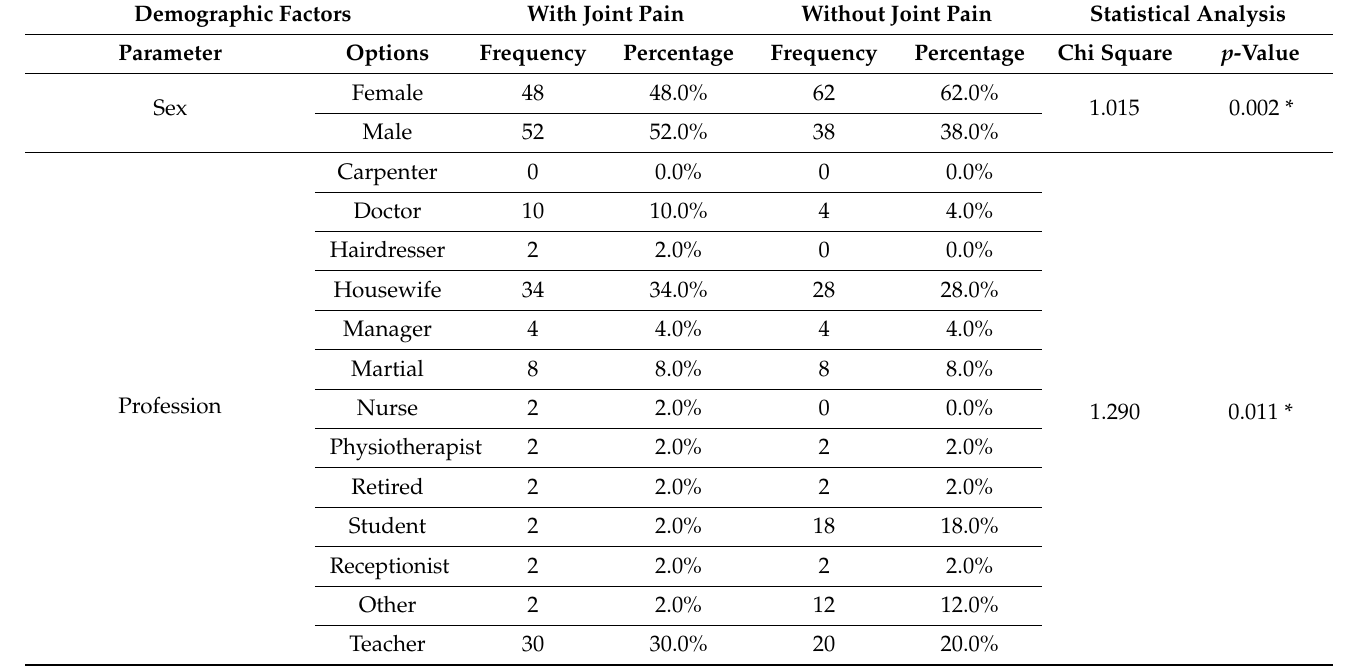
Table 2. Distribution of study subjects in both the groups according to demographic